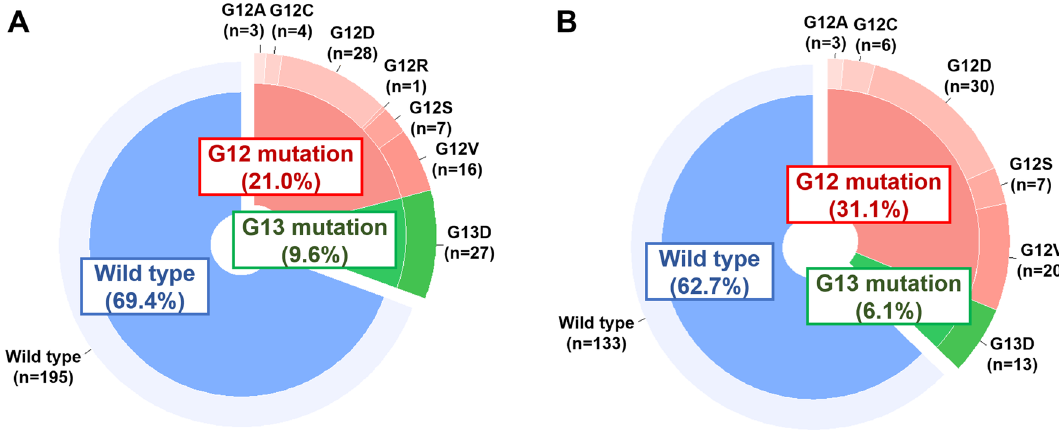
Figure 1. Distribution of KRAS -mutant and wild-type statuses in the ( A ) discovery cohort and ( B ) validation